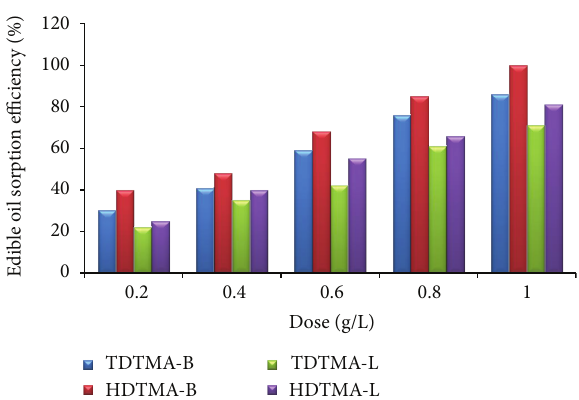
Figure 3: Removal efficiency of edible oil using HDTMA and TDTMA laterite and bentonite based Organoclays. Table 2: Sorption capacities of organoclays used in the study.